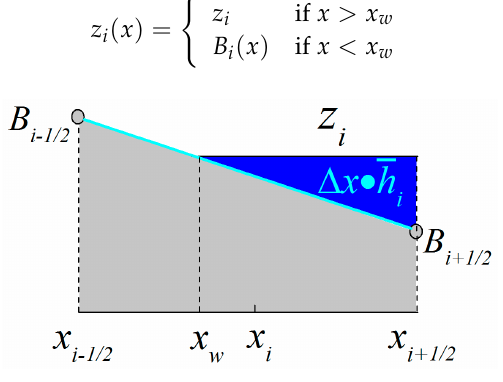
Figure 1. Correction for negative values of